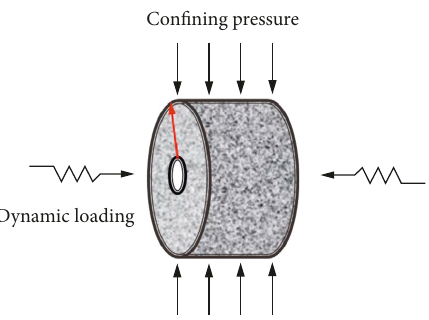
Figure 1: Sketch of the loading state of the